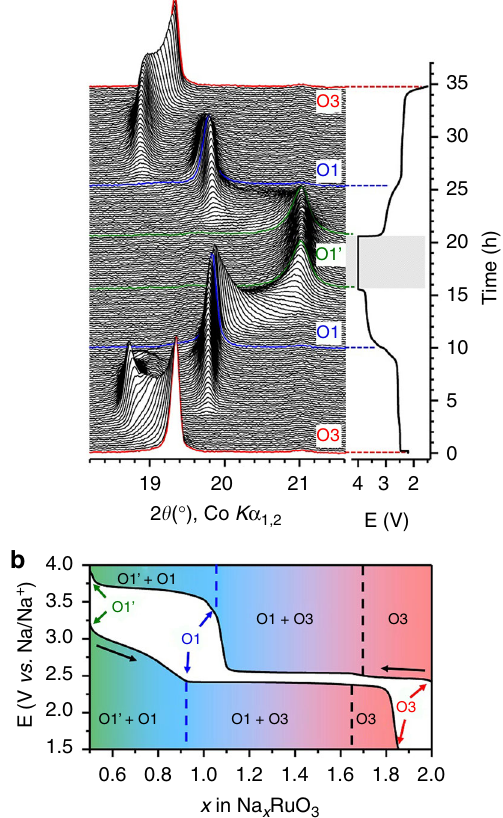
Fig. 2 Structural evolution upon charging/discharging Na 2 RuO 3 . a XRD patterns recorded in situ during the fi rst cycle of Na 2 RuO 3 with the corresponding cycling curve. The dashed area corresponds to a potentiostatic break whose aim was to ensure the equilibrium state at 4.0 V before discharging the cell. b Phase diagram as determined from the in situ experiment as a function of the sodium content